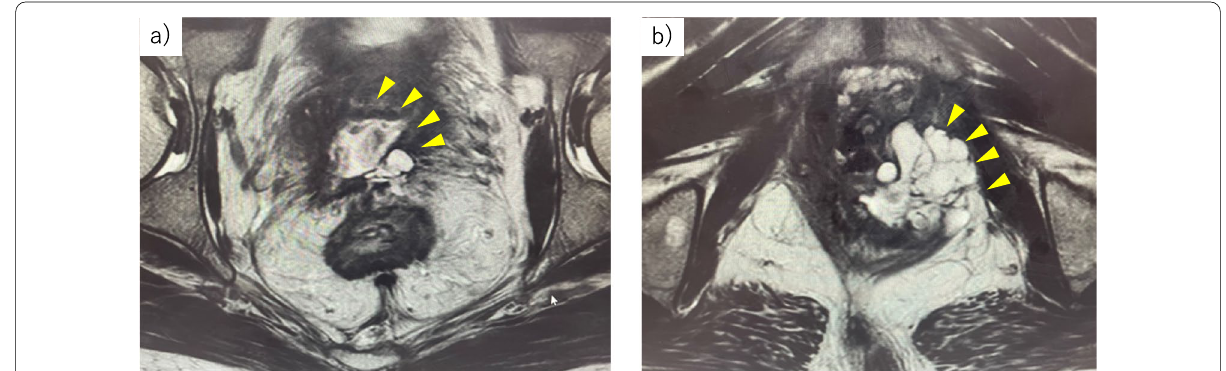
Fig. 1 T2-weighted axial magnetic resonance images of the pelvis a The tumor, including a mucin pool, had spread to the prostate (yellow arrowheads). b Beyond the levator ani muscle, the tumor had invaded the obturator internus muscle on the left side (yellow